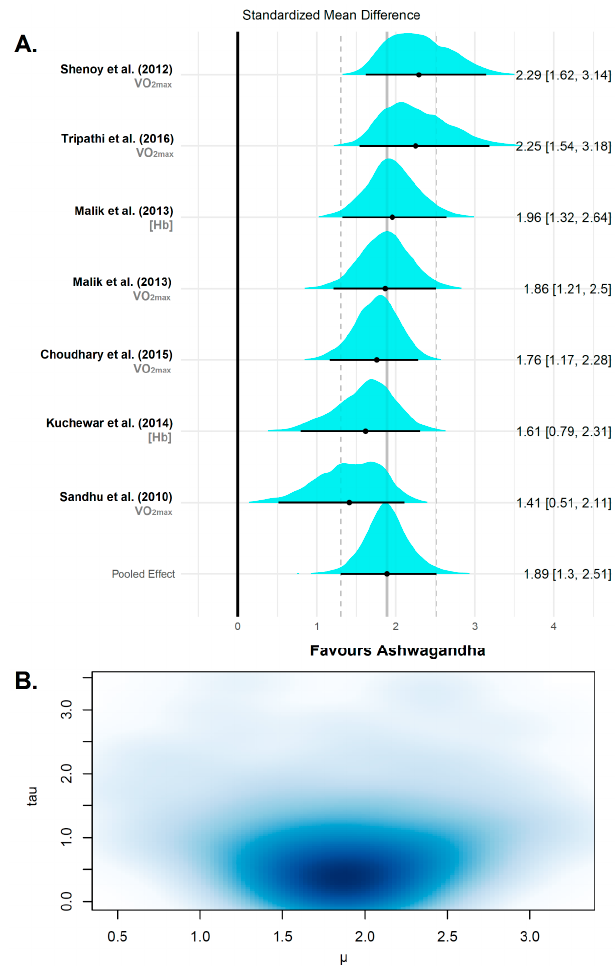
Figure 7. Forest plot of a random effect meta-analysis on cardiorespiratory fitness variables after Ashwagandha supplementation. ( A ) The plot shows the names of the studies with their respective variable or multiple comparison/multiple outcomes on the left. On the right are the θ k and 95% CrI. The value of the overall weighted mean of effect sizes is drawn as a vertical line in the middle of the plot, which represents the reference line to test the null hypothesis in each study. The posterior distributions of the estimated effect sizes for each study are shown as cyan densities. The black circle represents the posterior mean, and the horizontal line extending from the point is the 95% CrI. The bottom row is the meta-analytic effect size ( μ ). ( B ) multivariate kernel density estimation plot of the posterior distribution of μ (x-axis) and τ (y-axis) with the darker zone indicating increased plausibility of values.